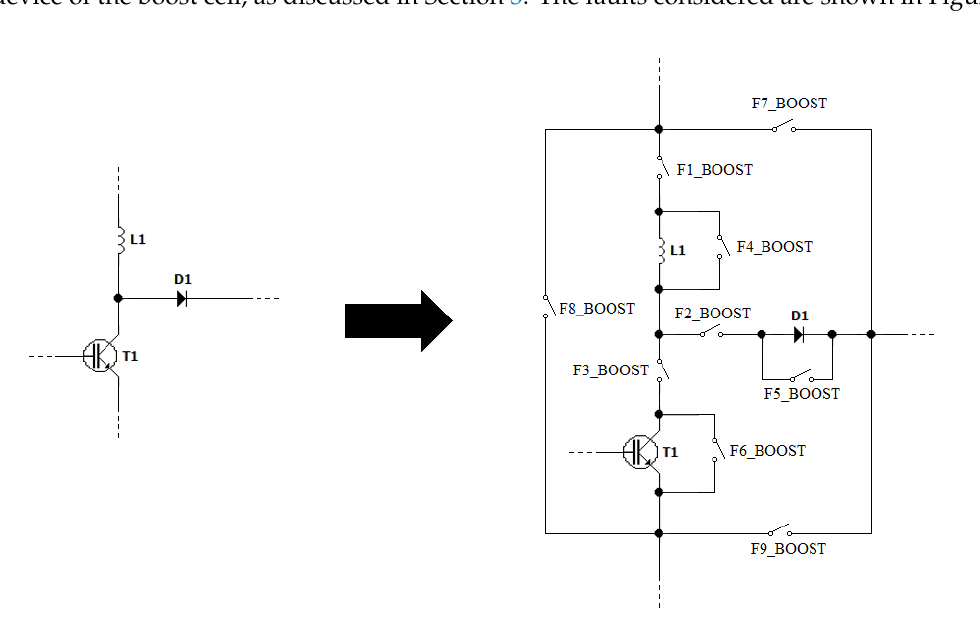
Figure 6. The faults considered in the boost cell.